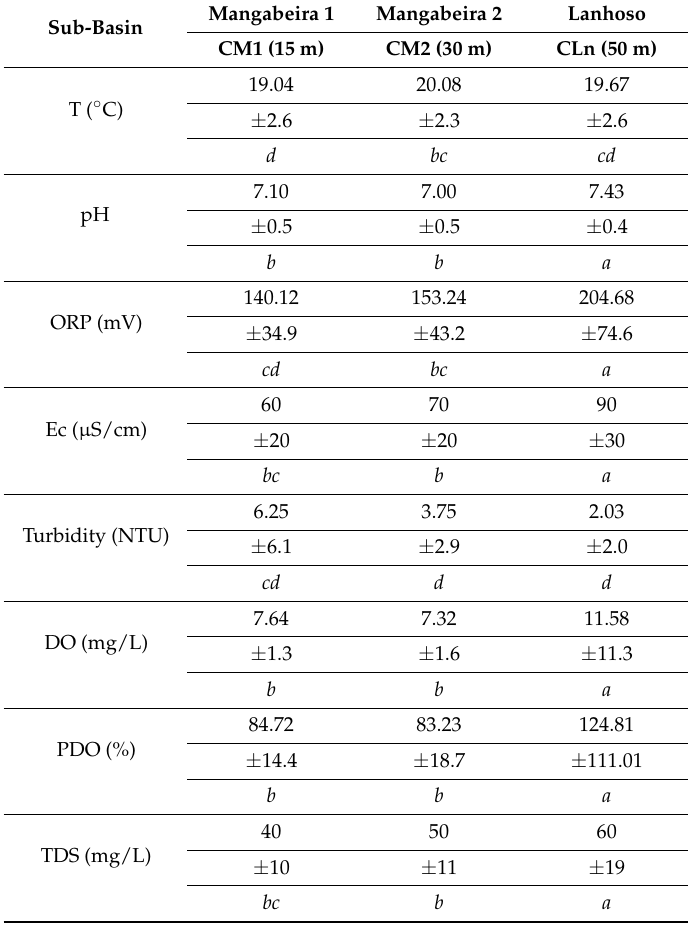
Table 3. Analytical results for the water samples: average value, standard deviation, Tukey’s mean test result (ANOVA; p < 0.05). The symbols were defined in the text (Section 2.3.2). Values with different label (lowercase letters a , b , c or d ) are considered significantly different from each other by the Tukey’s test, and therefore can be used to differentiate the